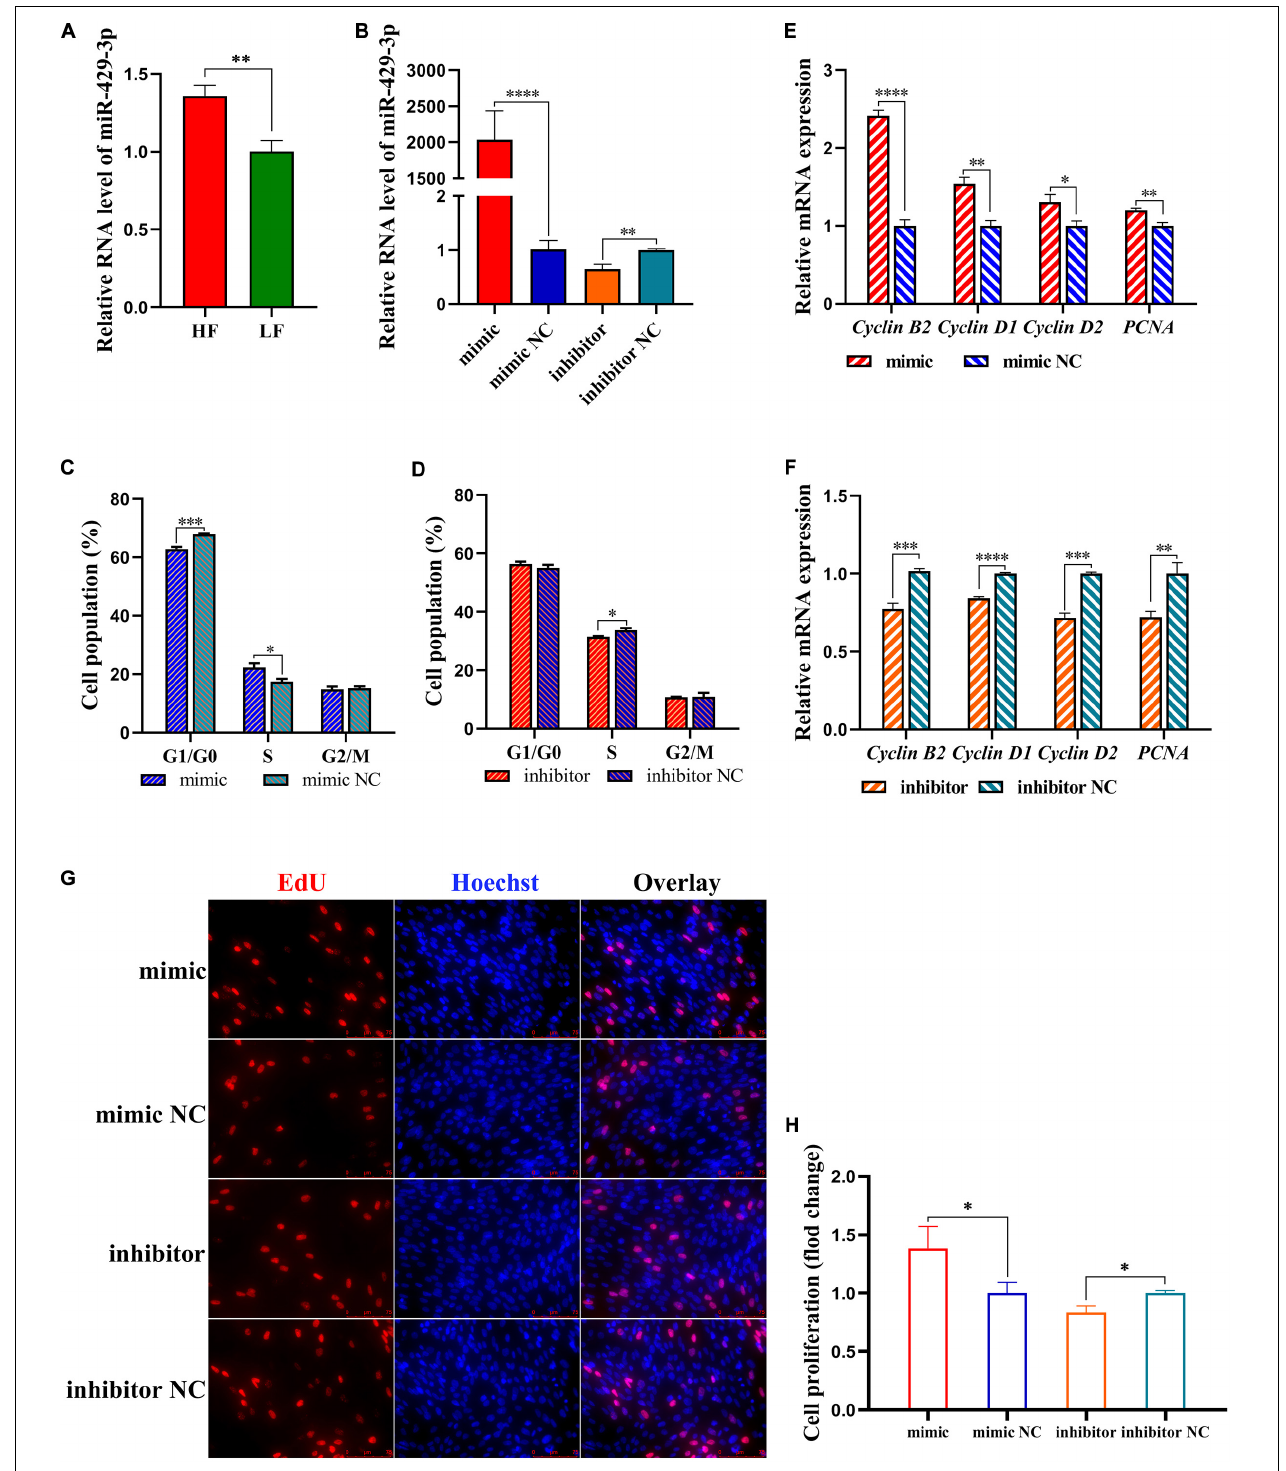
FIGURE 4 | miR-429-3p promotes preadipocytes proliferation. (A) Relative expression of miR-429-3p in high-fat chicken and low-fat chicken. (B) Transfection efficiency of miR-429-3p mimic and inhibitor. (C,D) Flow cytometry for cell cycle detection of ICP-1 cells. (E,F) Relative mRNA expression of Cyclin B2 , Cyclin D1 , Cyclin D2 , and PCNA in ICP-1 cells. (G,H) EdU staining for cell proliferation of ICP-1 cells. Data presented as mean ± SEM, * P < 0.05; ** P < 0.01; *** P < 0.001; **** P < 0.0001; ns: no significance.